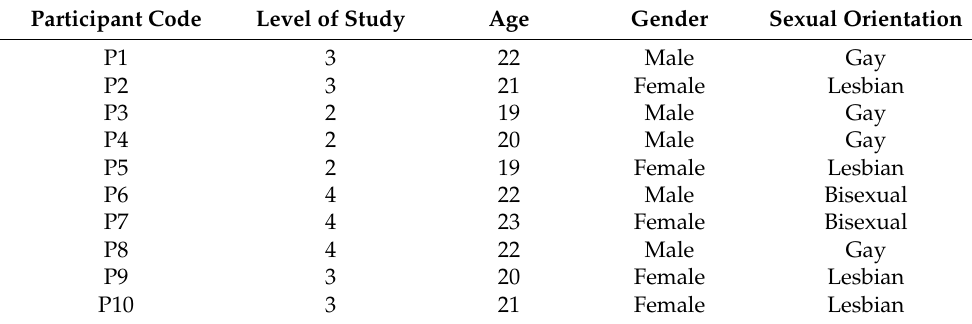
Table 1. LGB students’ demographic